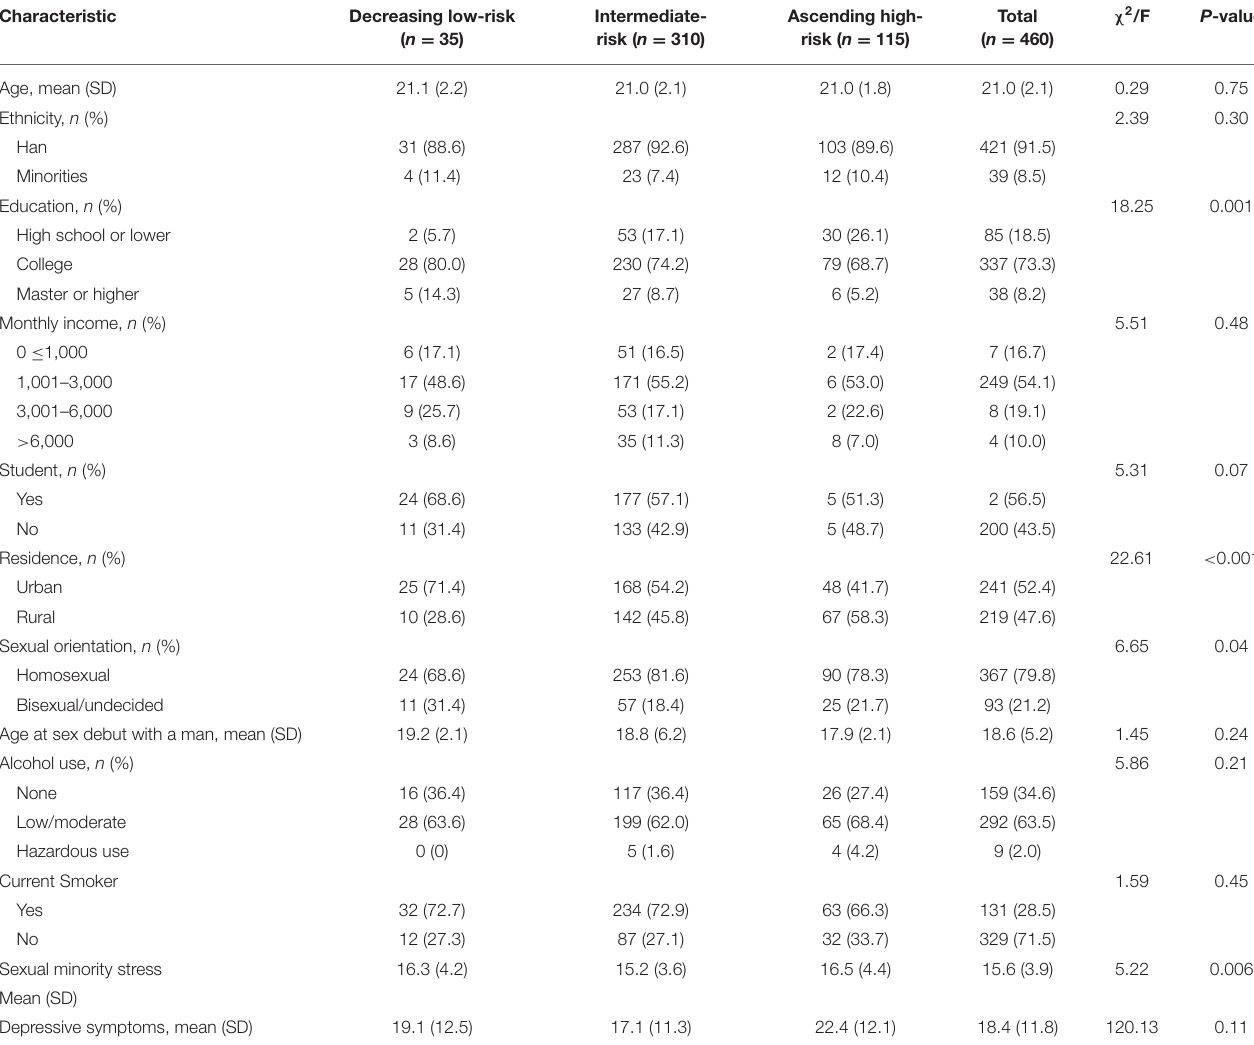
TABLE 3 | Characteristics of HIV-negative participants at baseline visit.